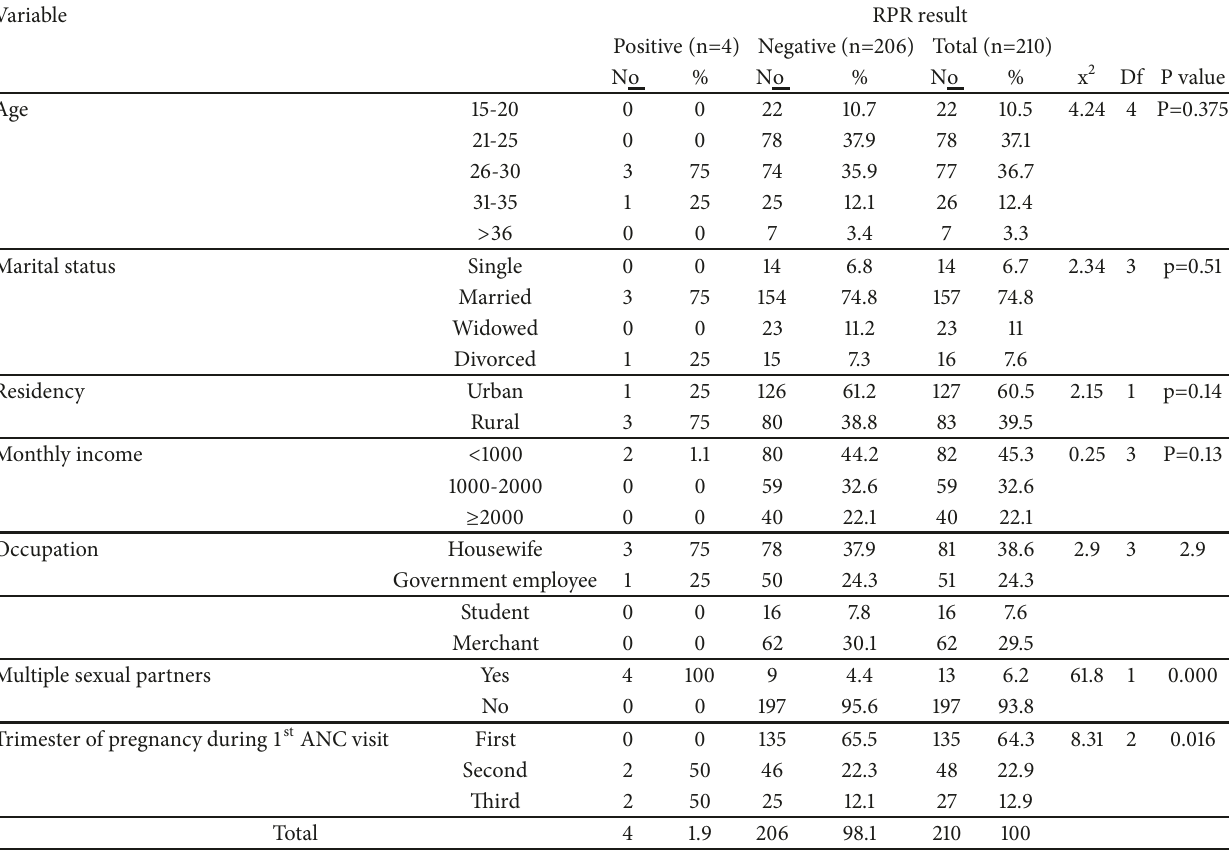
Table 1: Sociodemographic characteristics and syphilis serology status of pregnant women attending antenatal care clinic in Sede Muja district, South Gondar, Ethiopia,